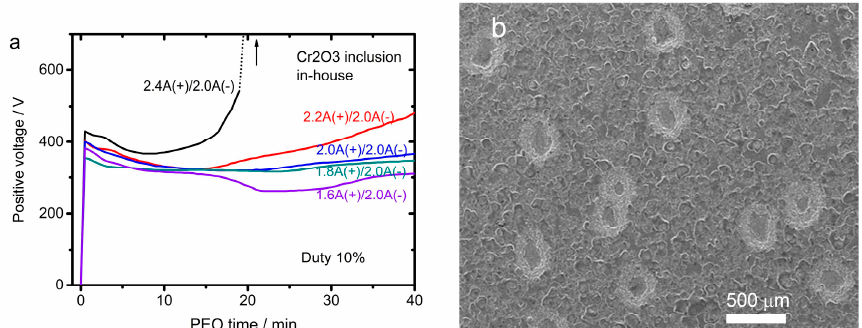
Figure 4. PEO with Cr 2 O 3 inclusions. Reprinted with permission from [103,104]; Copyright 2017 Elsevier, Copyright 2017 American Chemical Society. The ( a ) voltage profiles of constant current mode using pulsed current of bipolar waveform with various positive current settings; 2.4 A( + )/2.0 A( − ) denotes positive current 2.4 A and negative current 2.0 A for the 6061 sample of 21.7 cm 2 . Please note the positive voltage run away around 19.5 min. A typical ( b ) surface image of the coating sample, note that several small pieces of the coating are blown away, creating shallow dents of white color. The discharges, due to depletion layer at the Cr 2 O 3 /Al 2 O 3 interface, are violent, causing these shallow dents.